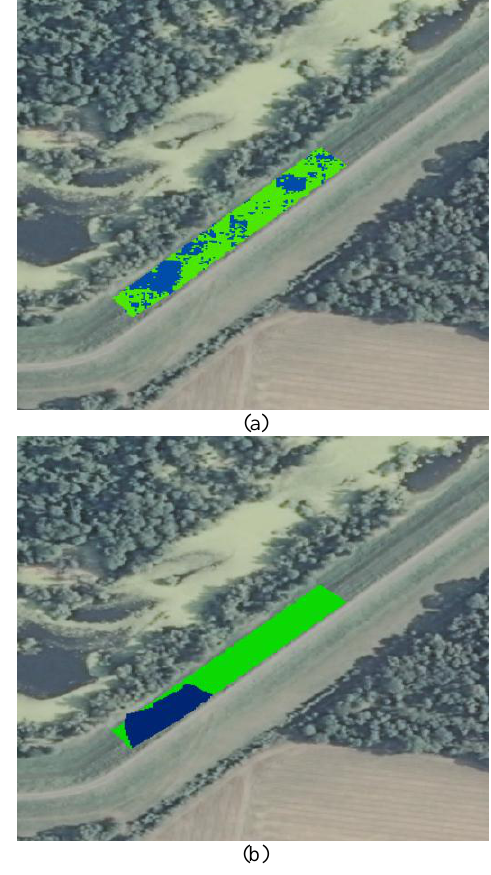
Figure 6. (a) Slide classification using the algorithm and TerraSarX data; (b) The ground truth data for testing area